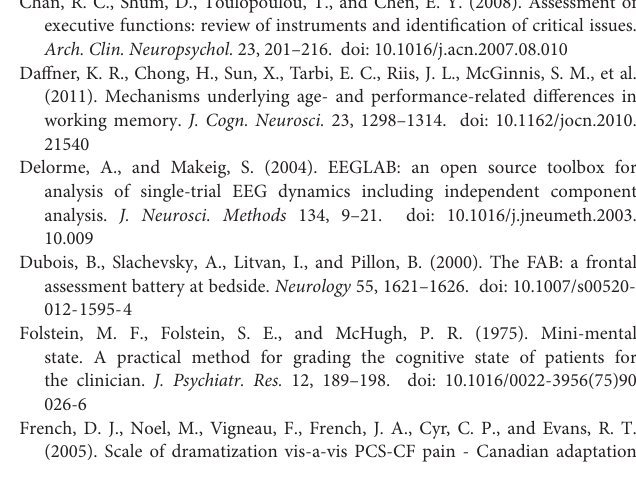
FIGURE S1 | Spectral power maps of alpha-band oscillations during resting-state (A) and significant tonic heat pain (B) . Statistical significance maps by paired t -test for each electrode and each group (C) , and significance maps after FDR correction (D) . FIGURE S2 | Spectral power maps of theta-band oscillations during resting-state (A) and significant tonic heat pain (B) . Statistical significance maps by paired t -test for each electrode and each group (C) , and significance maps after FDR correction (D)